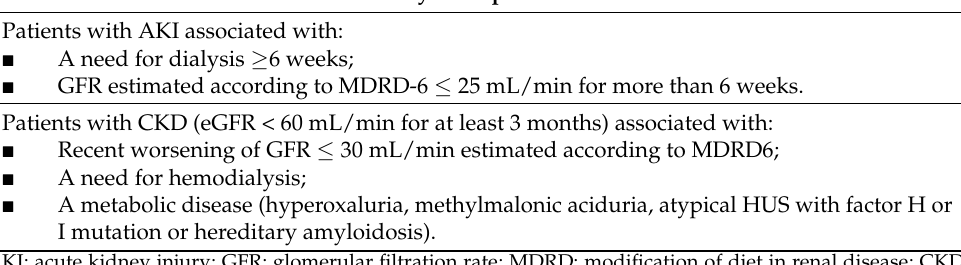
Table 1. Current indications for combined liver–kidney transplantation (OPTN 2017 recommenda- tions)